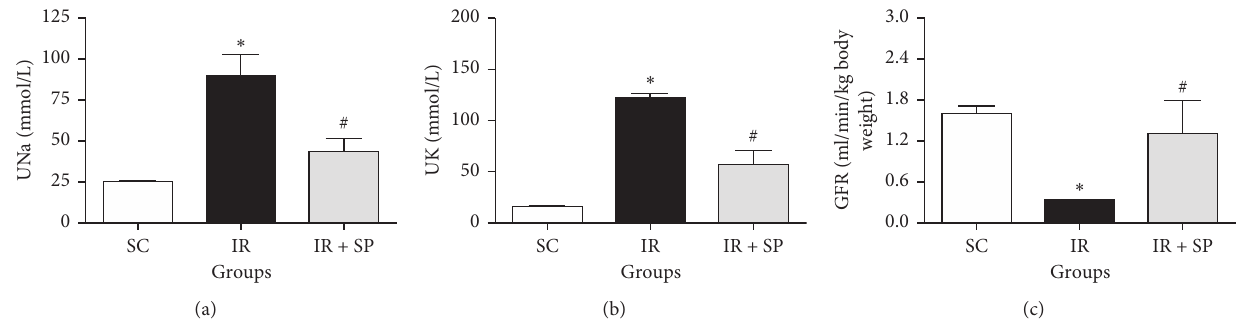
Figure 1: Effect of SP extract on UNa (a), UK (b), and GFR (c) following I/R injury. Data are shown as mean ± SEM. ∗ Significant against the SC group ( P < 0 . 001); # significant against the IR group. SC: sham control; SP : Stachys pilifera ; I/R: ischemia-reperfusion; UNa: urine Na